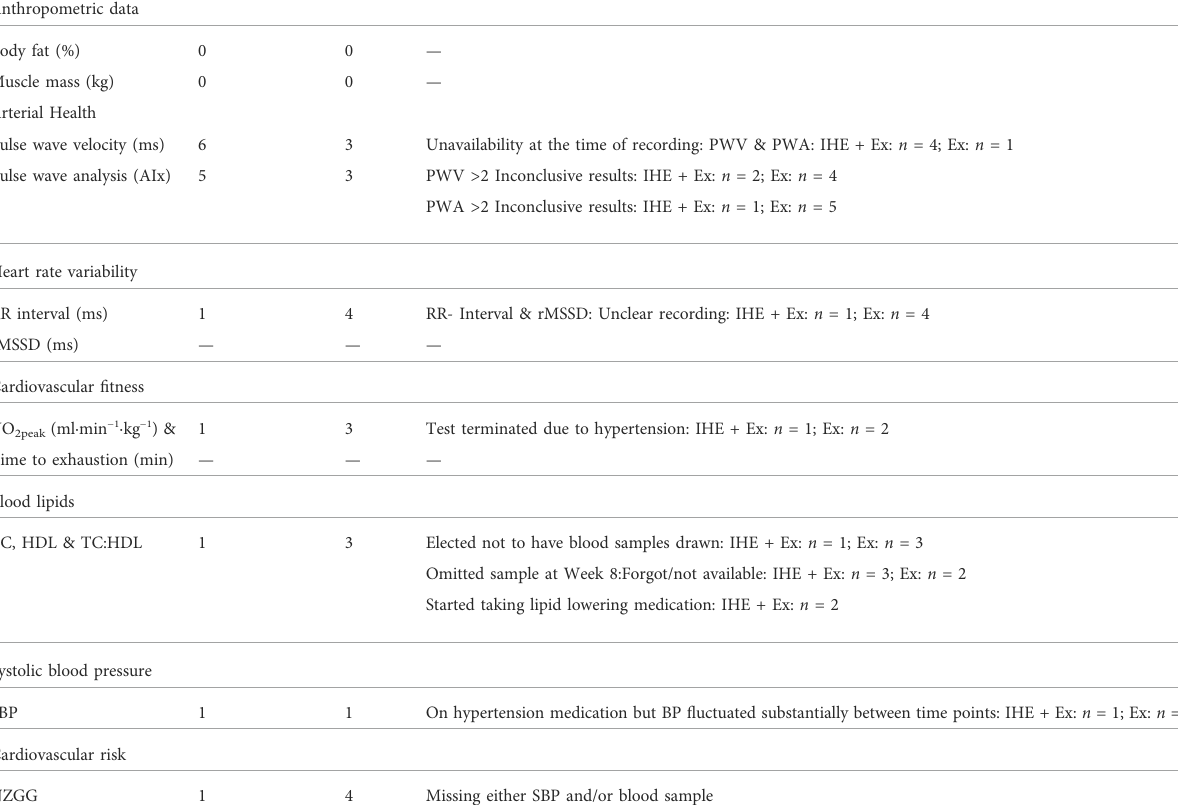
TABLE 2 Number of participants excluded from respective